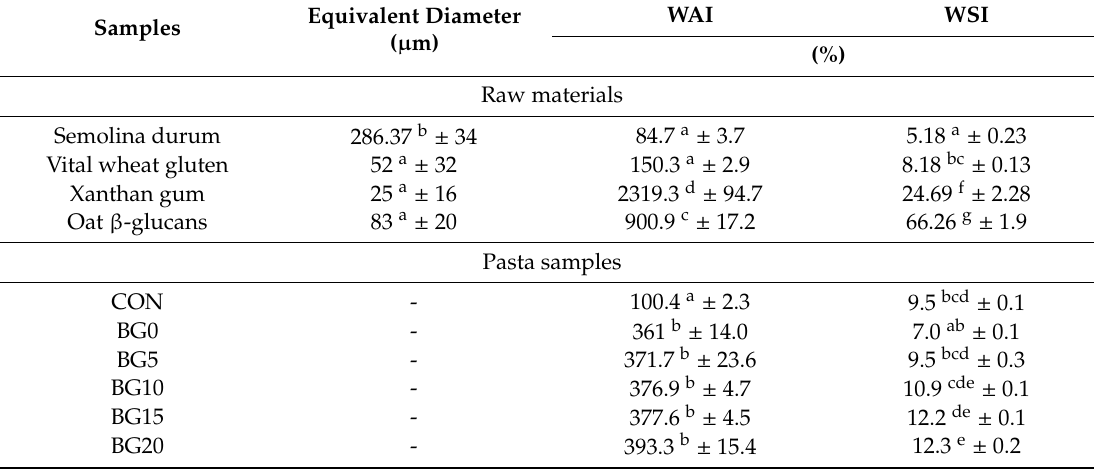
Table 3. Physical properties of raw material and pasta